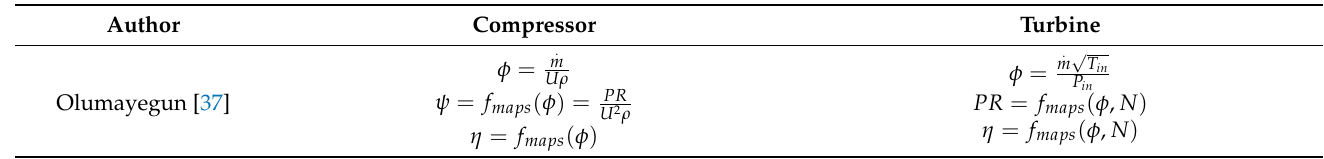
Table 7. Modeling of the turbomachinery in available